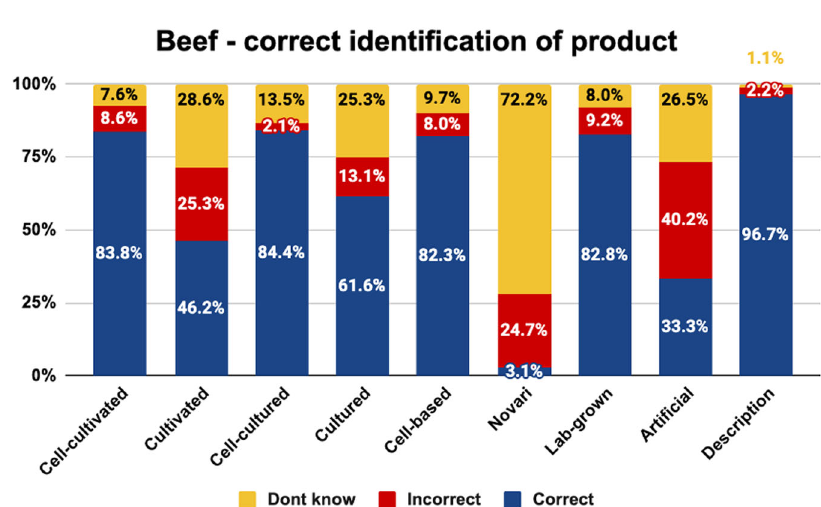
Fig. 1 Correct identi fi cation of beef by label. The graph shows the proportion of respondents who selected the correct or incorrect cell- cultivated beef product description, or did not know, by experimental